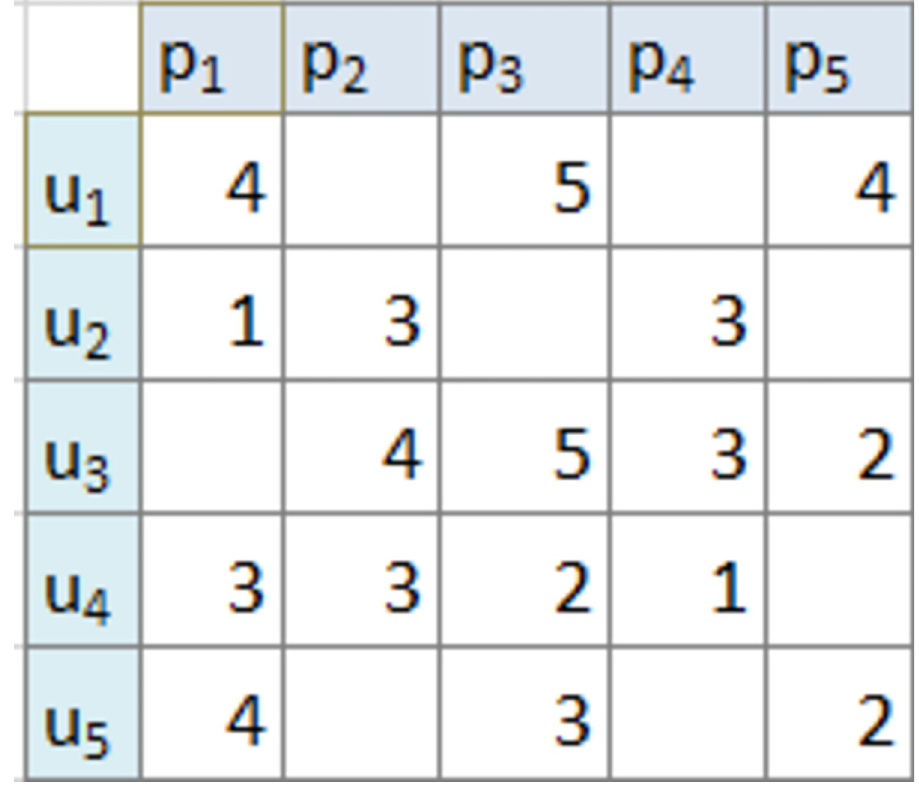
Fig 5. Sparse rating matrix for item p i for user u i